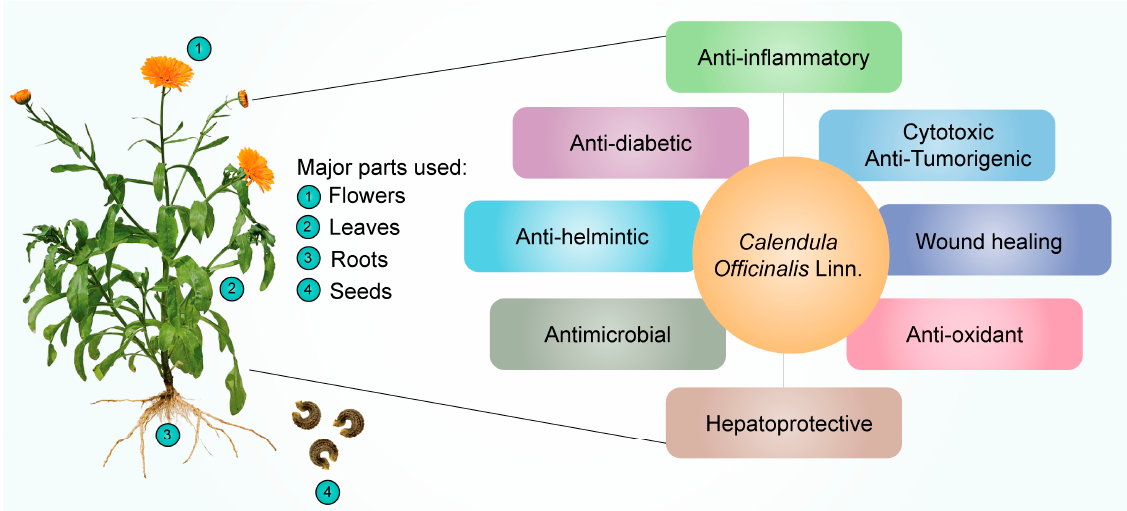
Figure 2. Pharmacological e ff ects of Calendula o ffi cinalis Linn. Table 3. Summary of clinical studies of the use of Calendula o ffi cinalis.